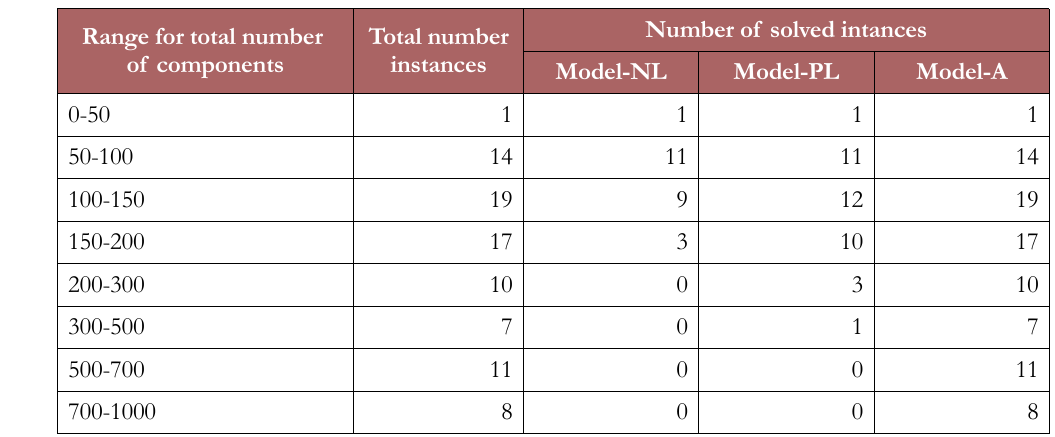
Table 3. Comparison of Model-NL, Model-PL, and Model-A respect to the number of components